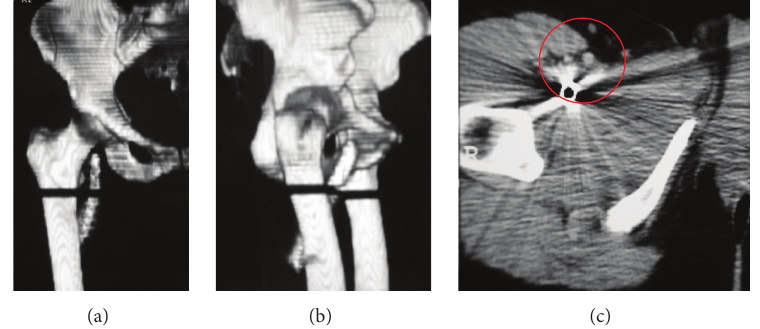
Figure 2: (a-b) CT-scan reconstruction. (c) Rod closeness to the femoral